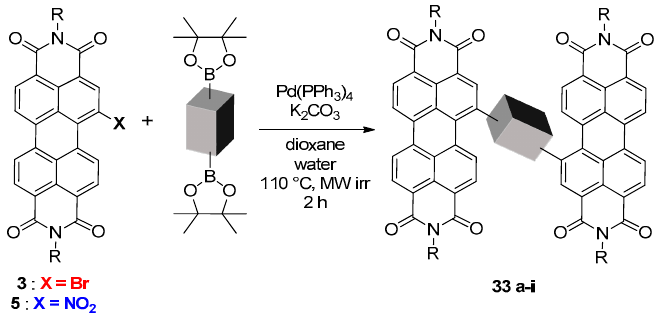
Scheme 7. PDI multimerization through SMC from 1-nitroPDI and 1-bromoPDI. R =